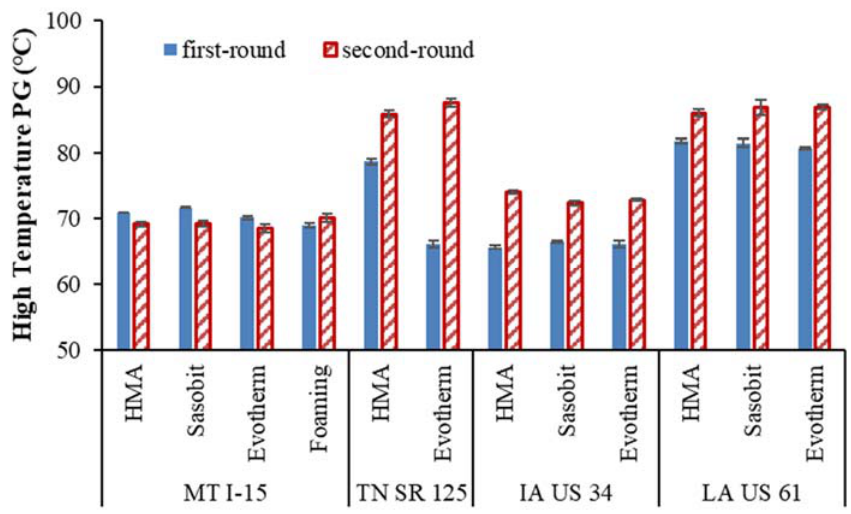
Figure 4. Comparisons of extracted binder high-temperature PGs.